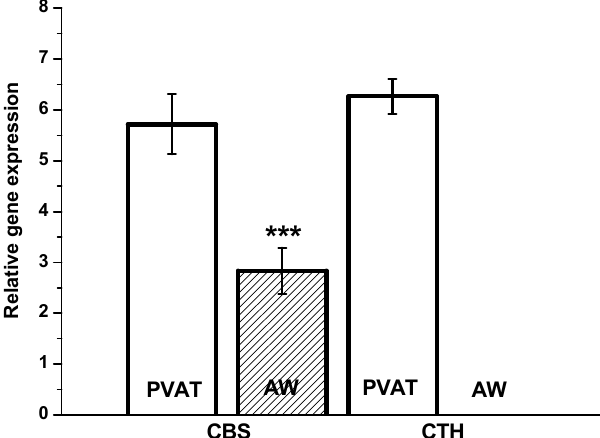
Figure 1. Gene expression of cystathionine beta-synthase (CBS) and cystathionine gamma-synthase (CTH) in perivascular adipose tissue (PVAT) and lobar arterial wall (AW) of all patients. The expression of genes was determined by real-time PCR. The obtained data were normalized to endogenous reference genes. The results are presented as the mean ± S.E.M, and di ff erences between tissues were analyzed by one-way ANOVA with Bonferroni post hoc test on ranks. *** p < 0.001 with respect to the CBS expression in PVAT.